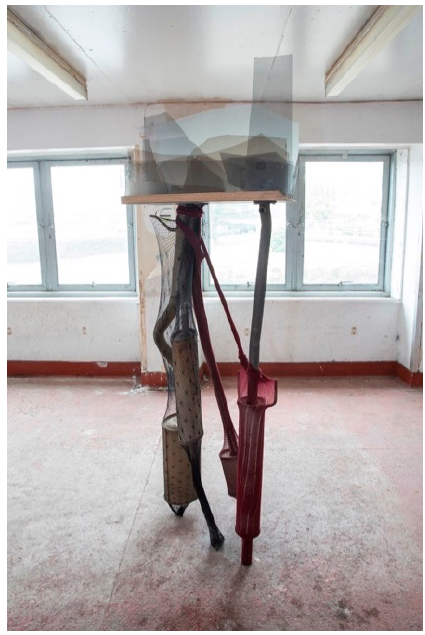
Figure 5. Matthias. 2016. True Skin featured in S-O-T Body Repairs exhibition.